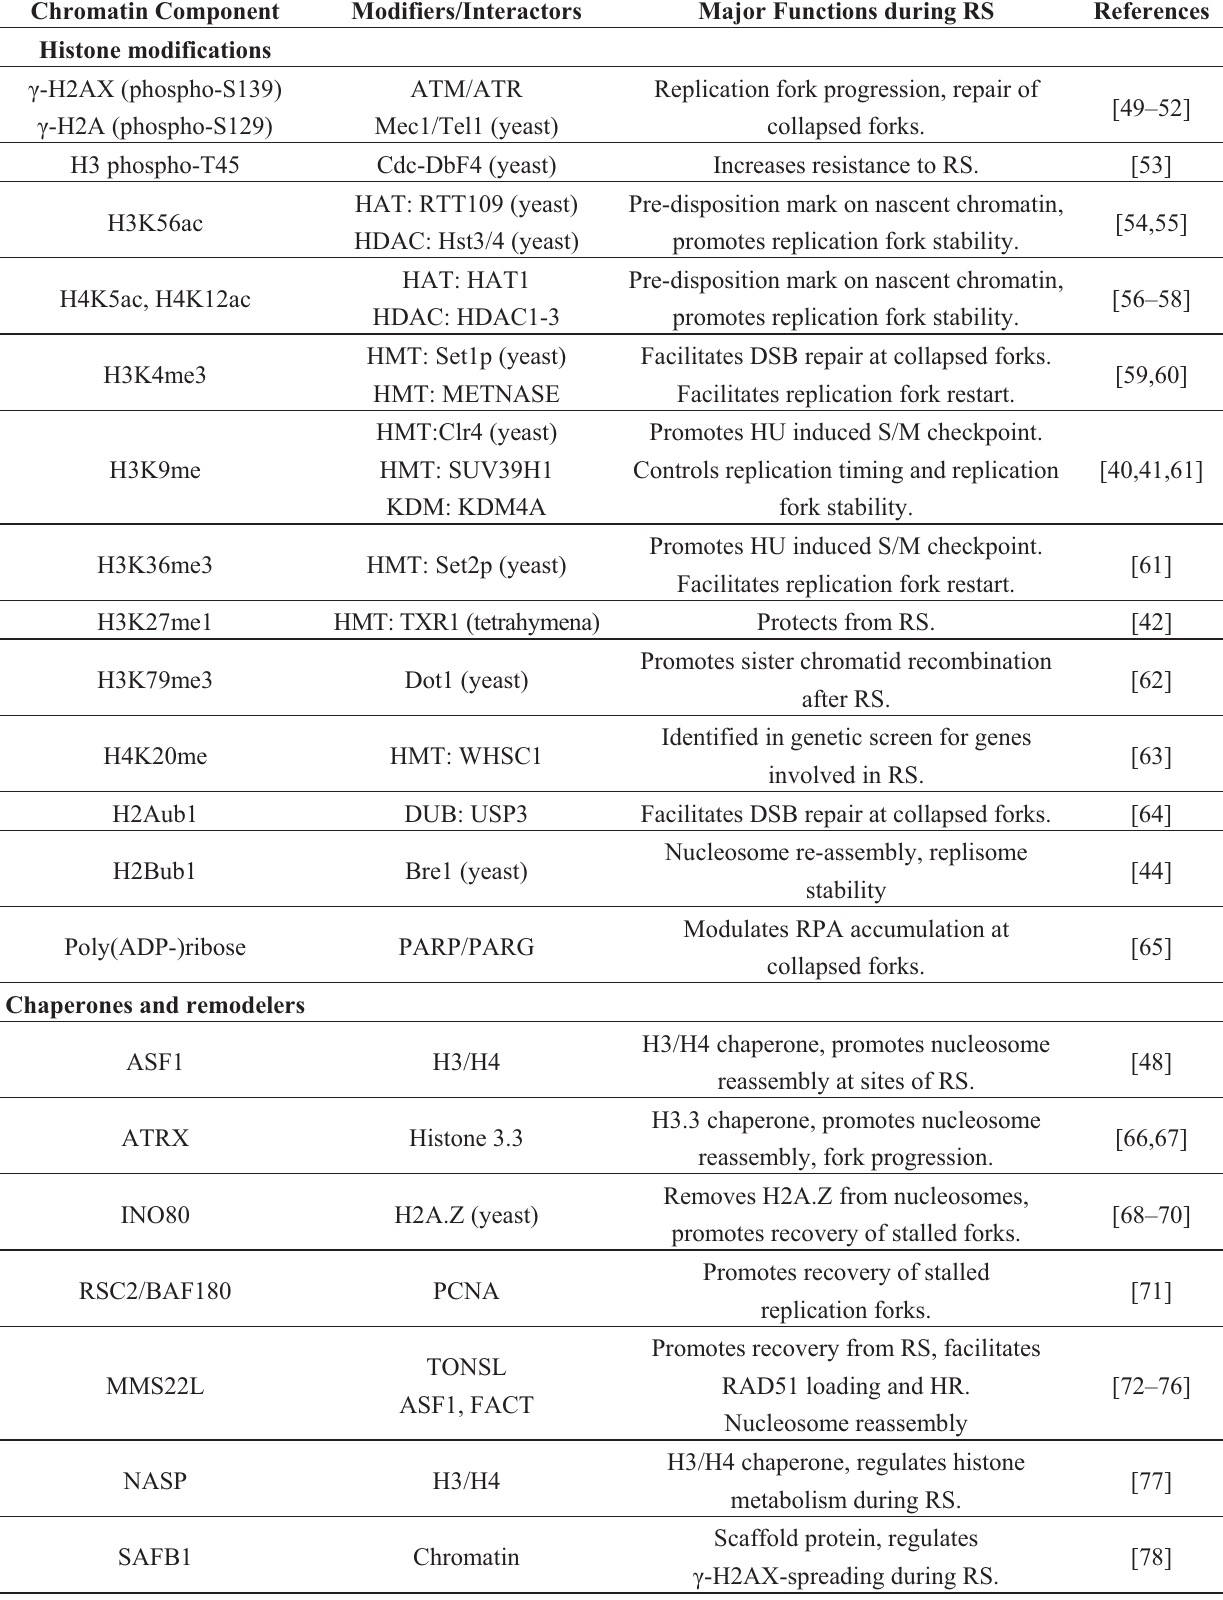
Table 1. Chromatin modifications and modifiers involved in replication stress (RS). Relevant in mammalian cells unless noted